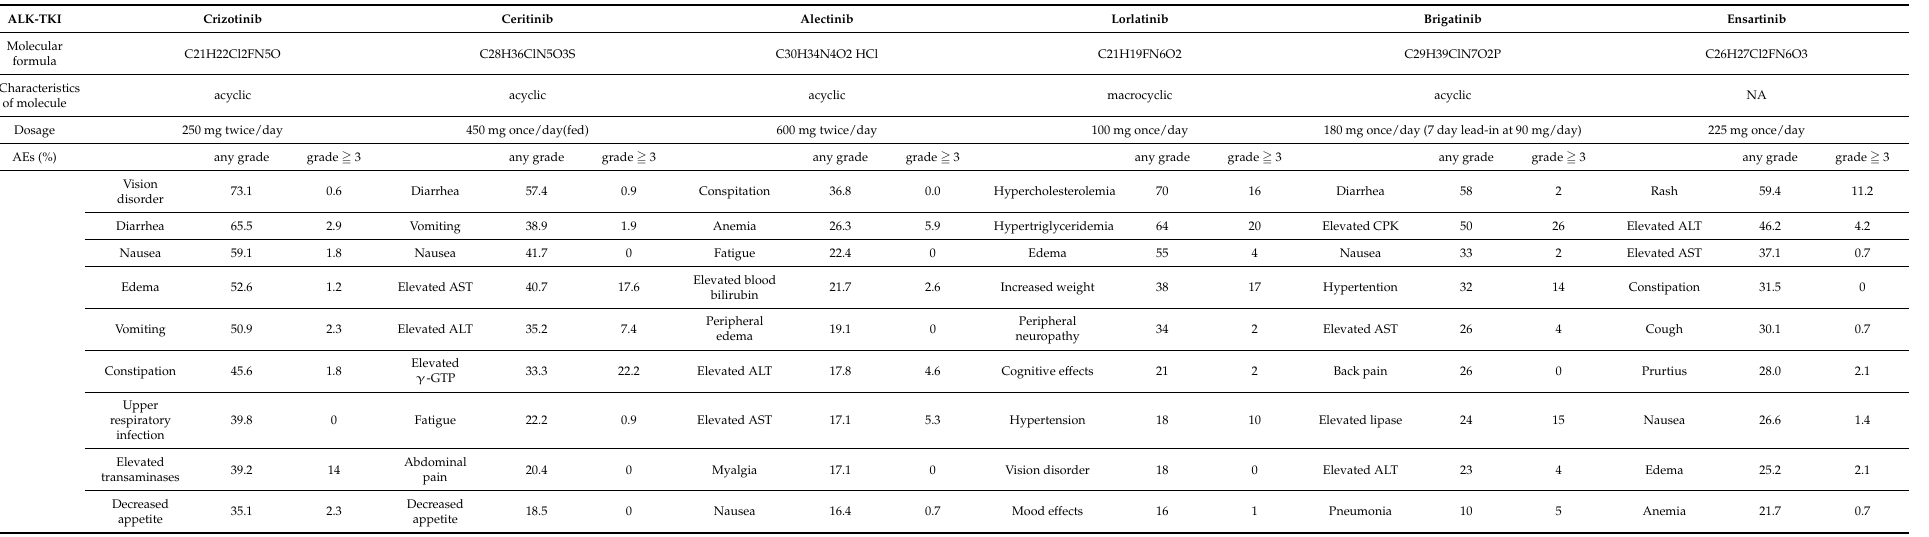
Table 4. Characteristics of molecule and common/typical adverse